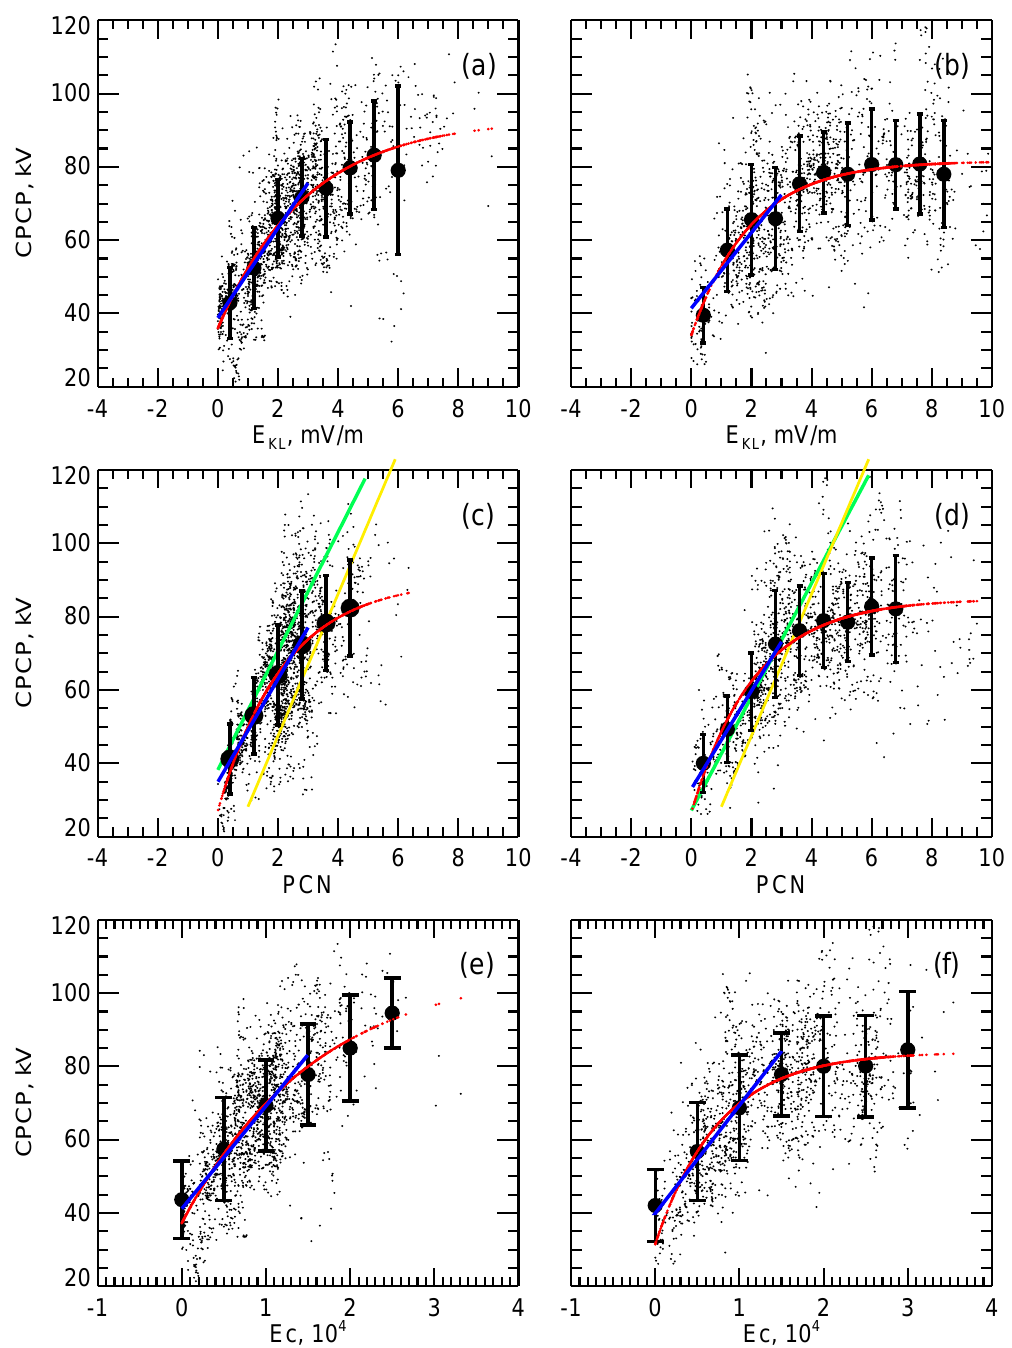
Fig. 2. (a) Scatter plot of the SuperDARN cross polar cap potential (CPCP) versus the E KL function for summer measurements. Also presented are the CPCP binned values (solid dots, 0.5mV/m step) and standard deviation for each bin. (c) The same as in (a) but versus the PCN magnetic index. The PCN bins are 0.5 units apart. The green line is the linear relationship obtained by Ridley and Kihn (2004) through AMIE modeling. The yellow line is the linear relationship reported by Troshichev et al. (1996). (e) The same as in (a) but for the Newell coupling function Ec. The bin width is 0 . 5 × 10 4 . Panels (b) , (d) , and (f) are the same as (a), (c), and (e), respectively, but for winter measurements. In all panels, overlaid red line is the exponential least square fit to original (non-binned) data and overlaid blue line is the linear fits to the increasing part of the plots. Parameters of the fits are given in Tables 3 and 1,